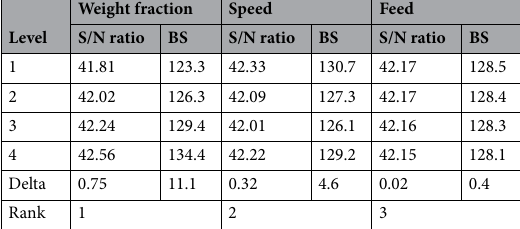
Table 8. Response table for S/N ratios and BS of drilled LFPP.